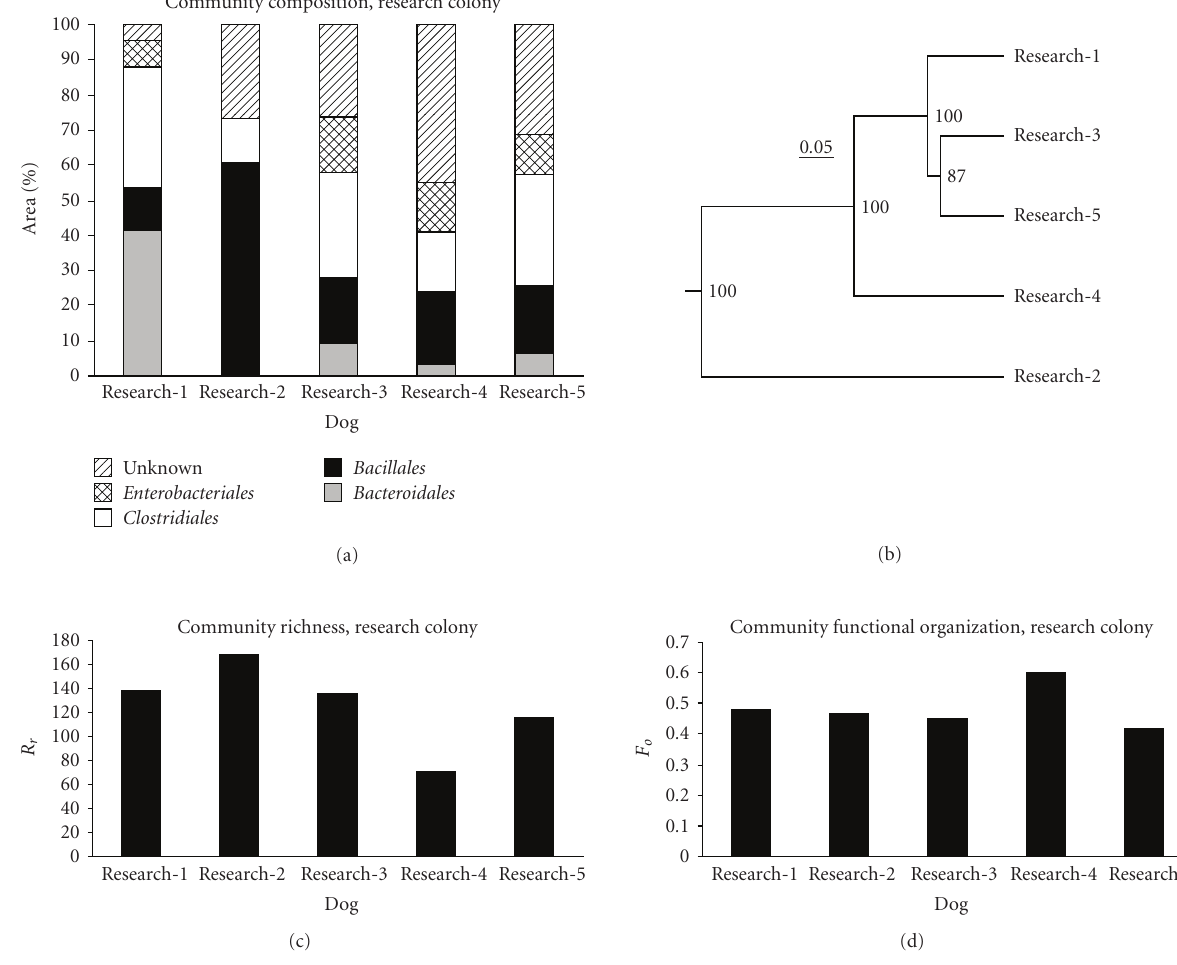
Figure 2: T-RFLP analysis of fecal samples from research colony dogs . Panel (a) community composition expressed as % area of peaks under the T-RFLP electropherogram; bacterial groups were combined at the taxonomic level of order. Panel (b) dendrogram based on Bray-Curtis similarities of community composition among the five dogs; numbers at nodes indicate percentage of trees having an equivalent node in jackknife analysis. Panel (c) community richness parameter, Rr . Panel (d) community functional organization, Fo